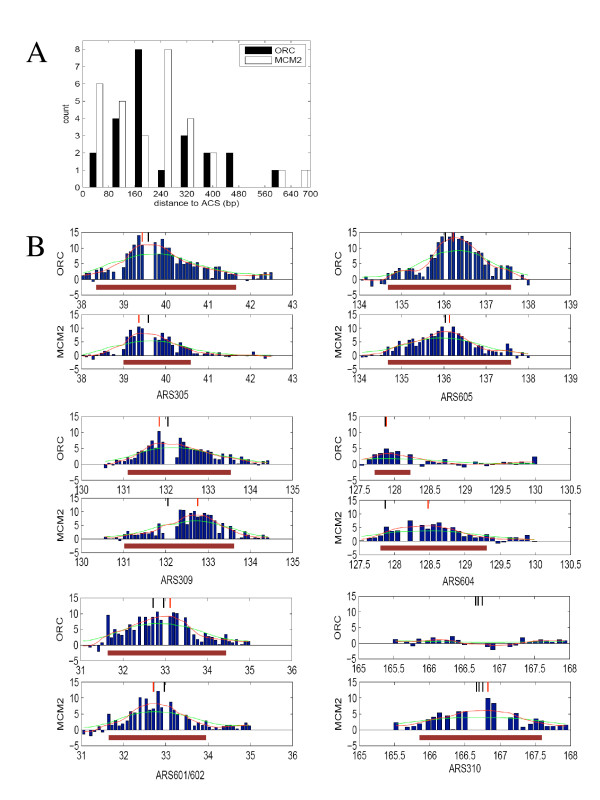
Known ACSs' locations relative to ORC and MCM2 peaks. A. Distance of known ACSs to closest ORC peak and MCM2 peak. B. Relative locations of ACS and ORC peak or MCM2 peak. The x-axis indicates the coordinates of probes on chromosomes in kilobases. The y-axis indicates signal strength by Z-value. The red tick attached to the top axis denotes the ORC or MCM2 peak and the black tick denotes the ACS location. The blue bars represent the Z-value at specified probe coordinates. The red and green lines indicate the smoothed Z-value (sZ) and average Z-value (avgZ) respectively. The horizontal red bar marks the regions called by HMM. For ARS305 and ARS605 both the ORC and MCM2 peaks are very close to the ACS location; for ARS309 and ARS604 the ORC peaks are located close to the ACS, but the MCM2 peaks are quite far due to shifted signal; ARS601/ARS602 and ARS310 have multiple proximate ACSs but do not confer multiple peaks in the data. Many ARSs show missing probes in the ACS region (15 out of 31 known ACSs have missing probes corresponding to the ACS).